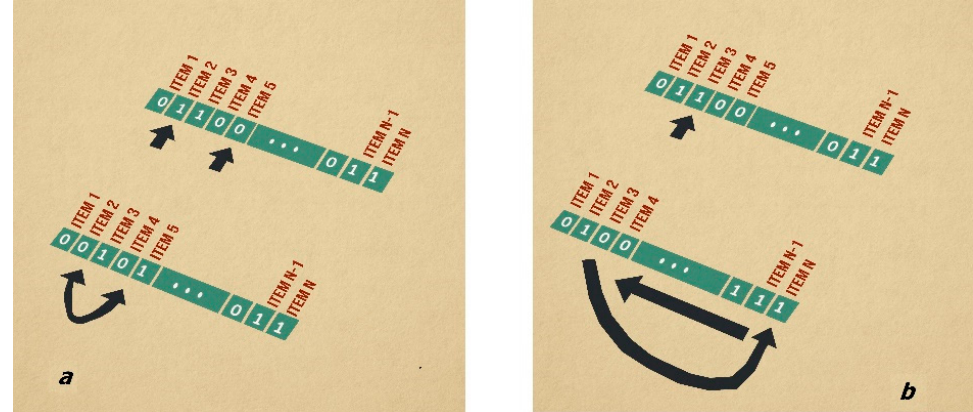
Figure 5. Construction of a neighboring solution. ( a ) The swap process to create a neighborhood solution; ( b ) shifting process to create a neighborhood solution.